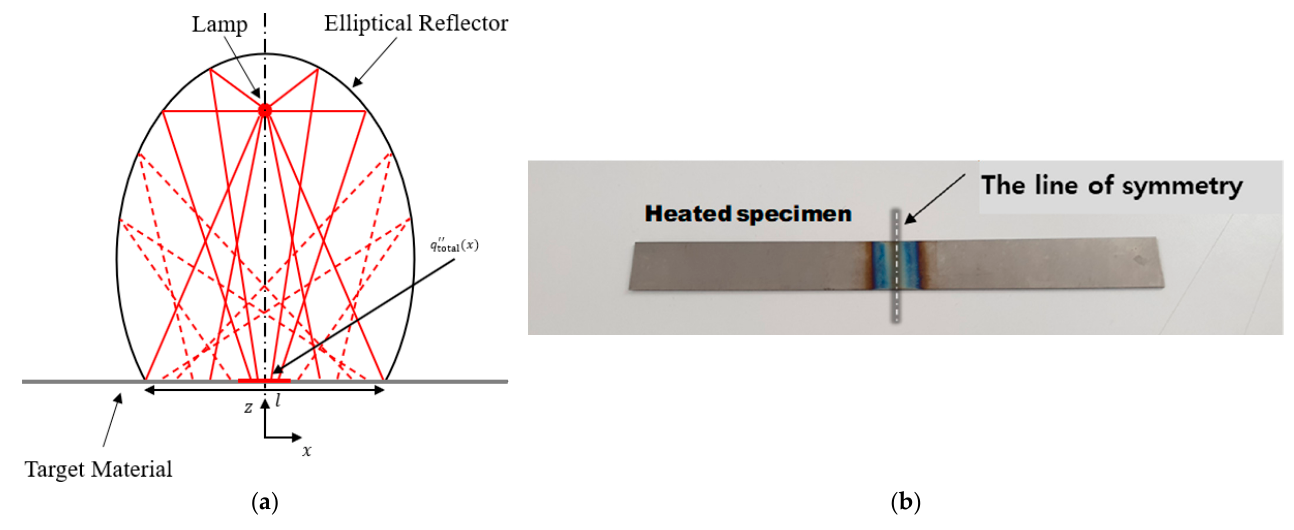
Figure 1. Focused IR heating method: ( a ) Illustration of the focused IR heating; ( b ) Example of a specimen heated by the IR heating [22].